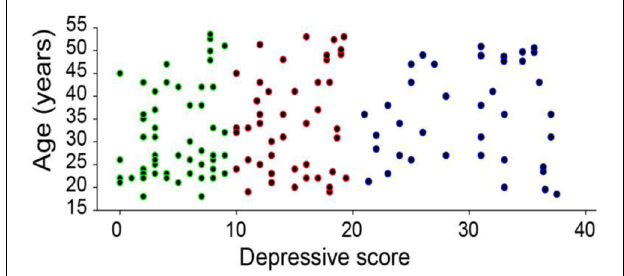
FIGURE 1 | The distribution of the subjects and their scores in Hamilton Depression Scale. The control group scored less than 10, while